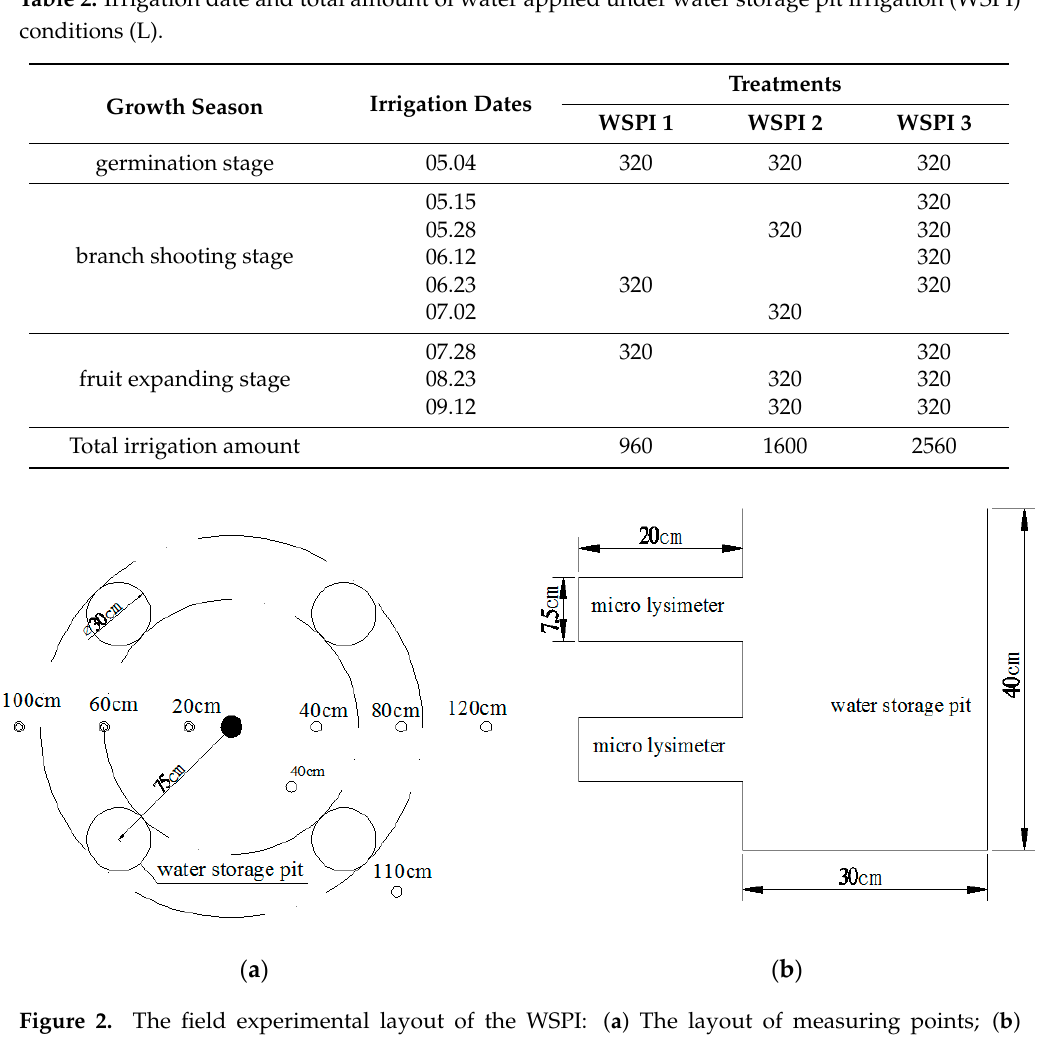
Figure 2. The field experimental layout of the WSPI : ( a ) The layout of measuring points; ( b ) The layout of water storage pits. ● , ○ and ◎ are the apple tree, moisture measuring tube and micro-lysimeter, respectively.